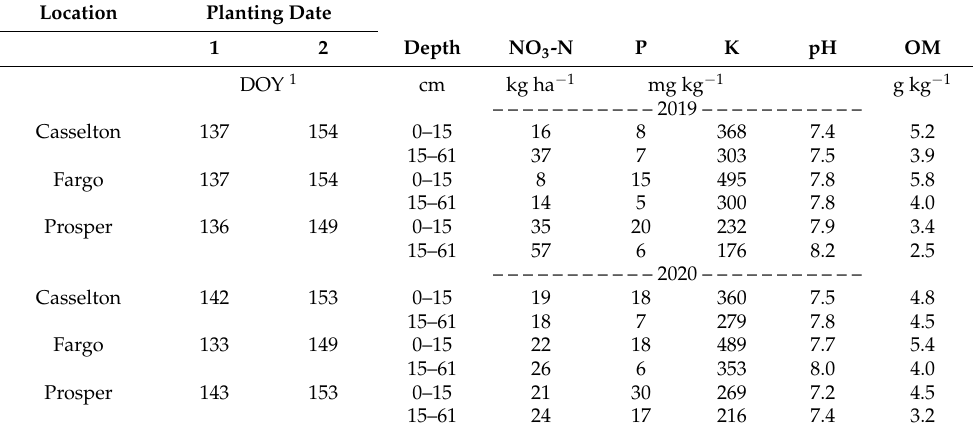
Table 2. Planting date and soil test results for soybean environments in 2019 and 2020.